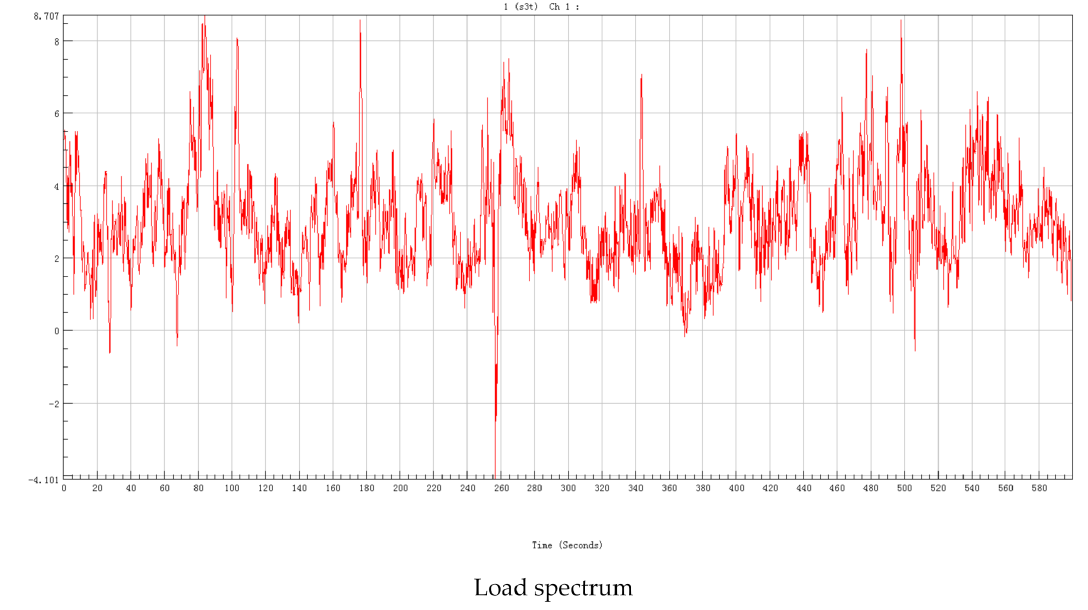
Figure 6. Ncode analysis.